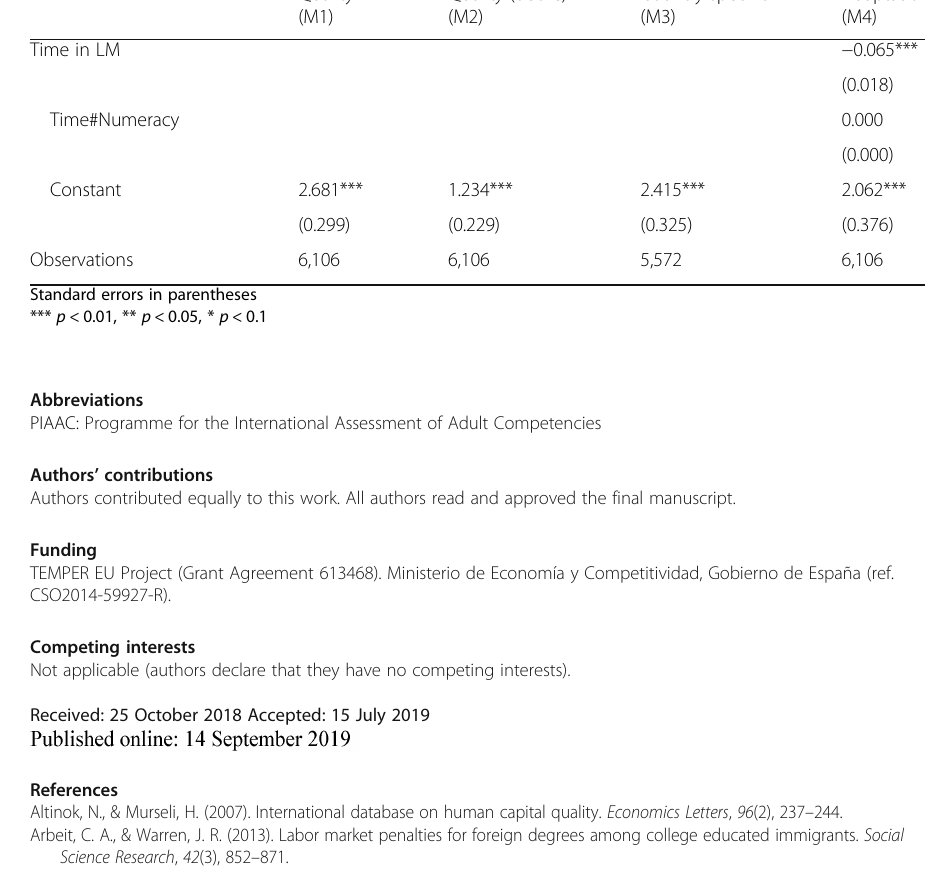
Table 6 Logistic regression on the probability of being unemployed. Explanations for the ethnic gap between natives and immigrants settled in UK